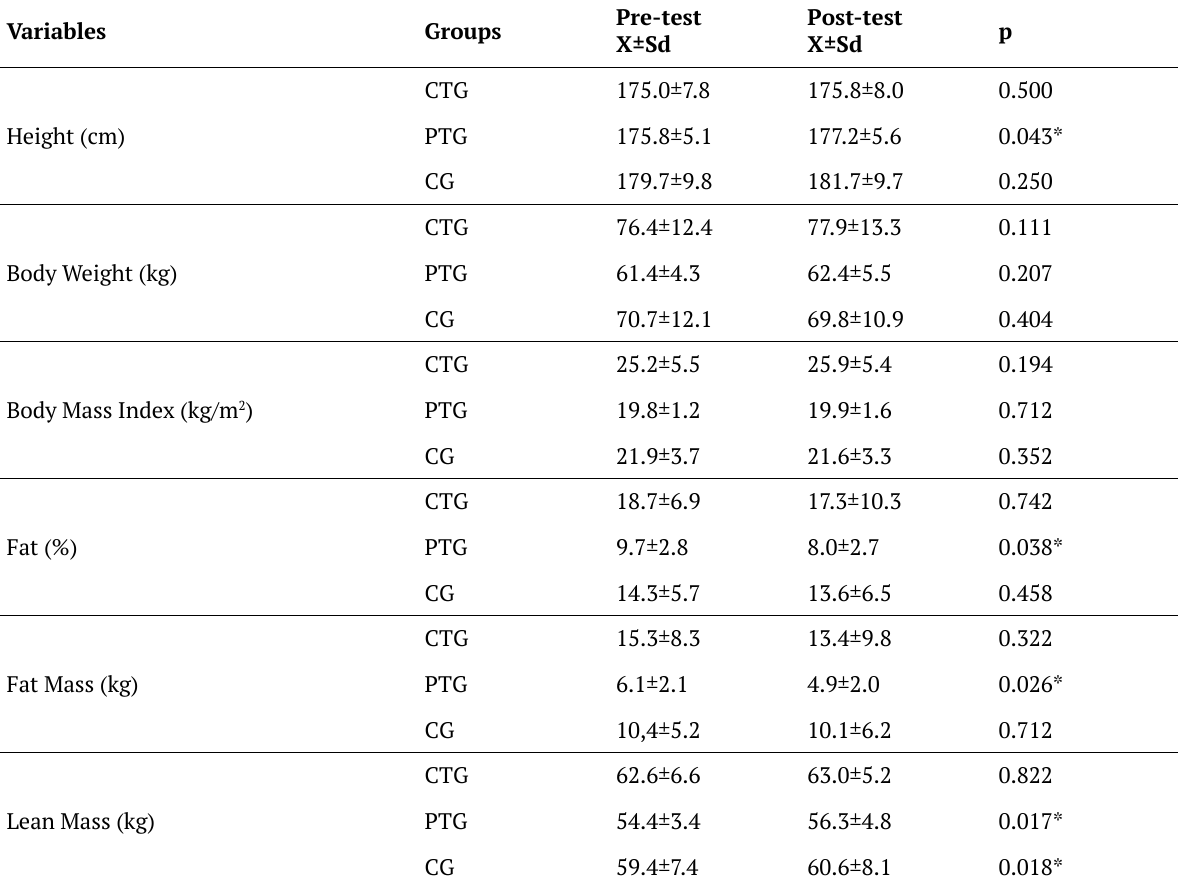
Table 4. Comparison of in-group body composition data of young male soccer players before and after core and plyometric training